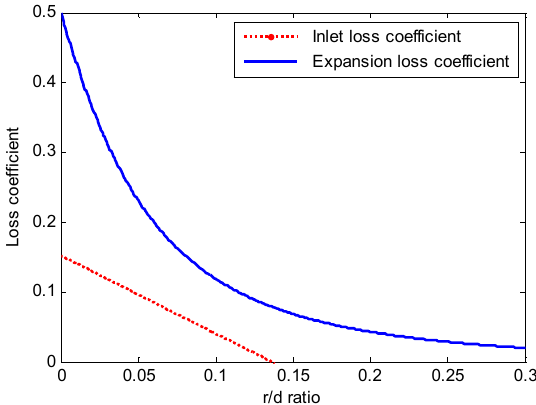
Figure 3. Inlet and expansion loss for different 𝑟 𝑑⁄ .